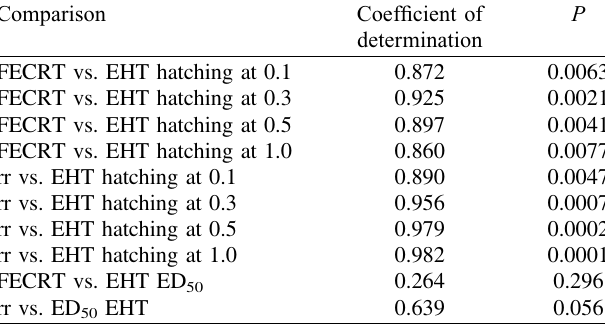
Table 3. Coef fi cients of determination and p values for comparing the results of the faecal egg count reduction test (FECRT), percentage hatching in the egg hatch test (EHT) at the four highest concentrations of thiabendazole ( l g/mL), frequency (%) of the rr genotype, and ED 50 in the EHT in the experimental infections with Haemonchus contortus .